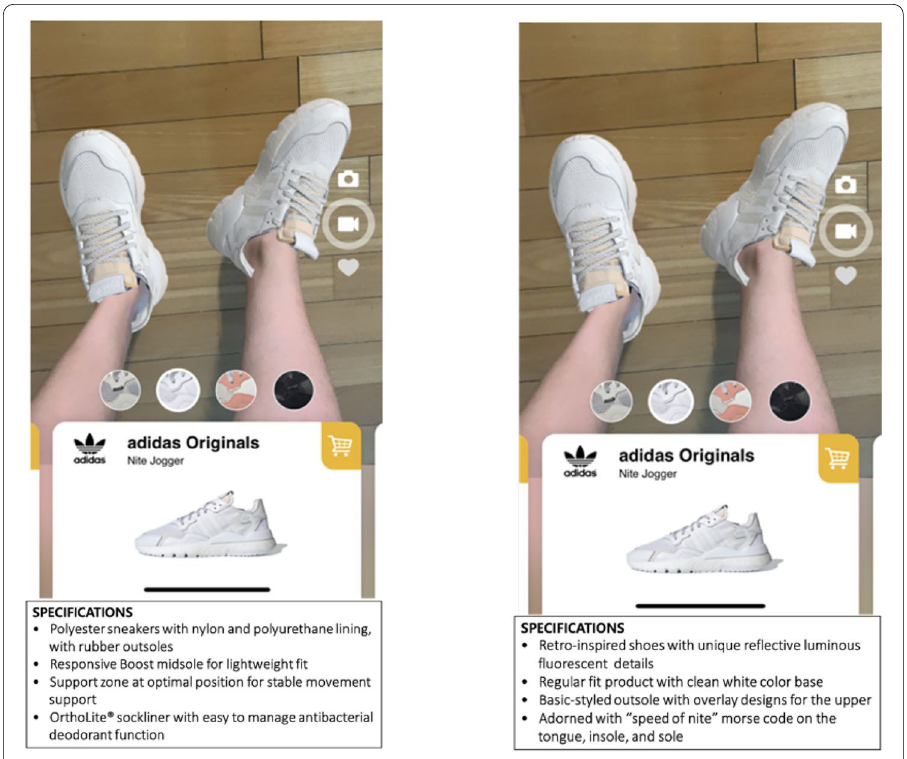
Fig. 2 Stimuli of utilitarian (left) and hedonic (right) attribute information